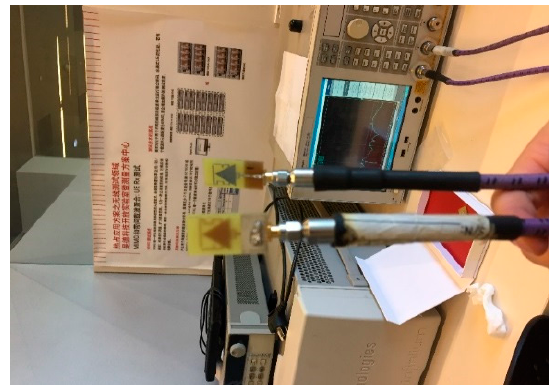
Figure 17. S21 test environment of the proposed antenna.